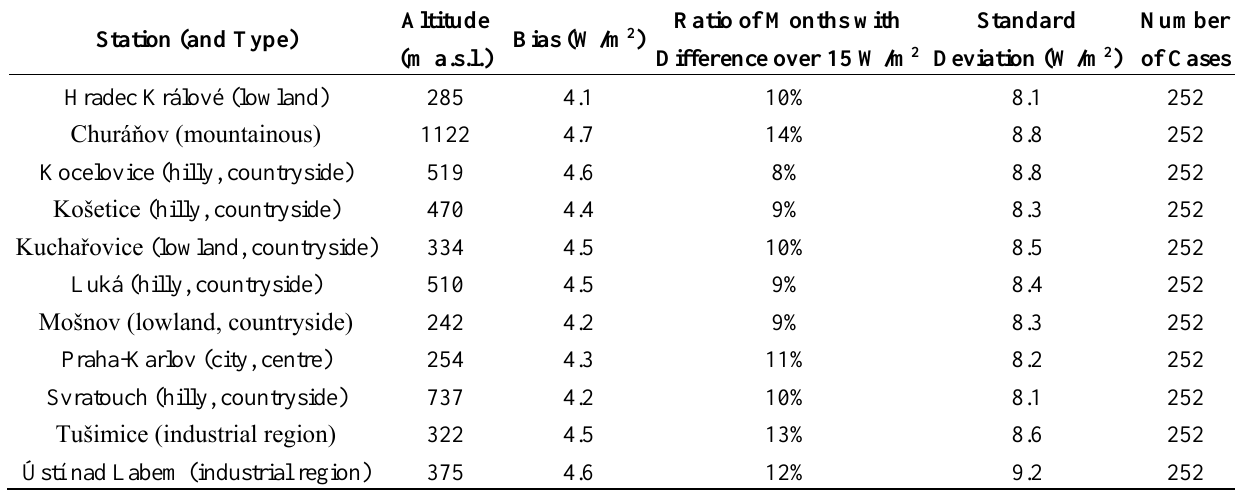
Table 1. Basic statistics of comparison between SIS (surface incoming shortwave) data from CMSAF (Satellite Application Facility on Climate Monitoring) (SIS product) and the surface station observations at a monthly time